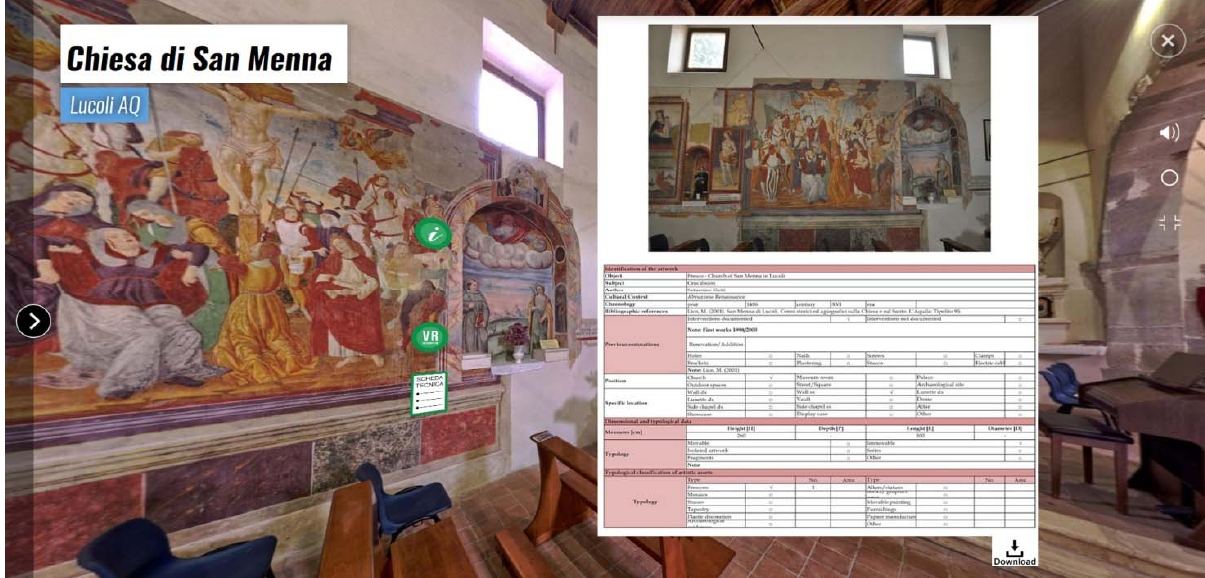
Figure 9. Virtual tour screenshot, SeVAMH